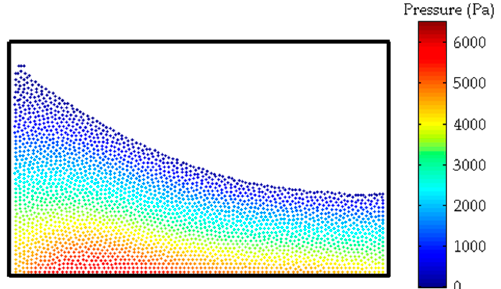
Figure 27. Flow pattern and pressure distribution in the SPH simulation without the baffle